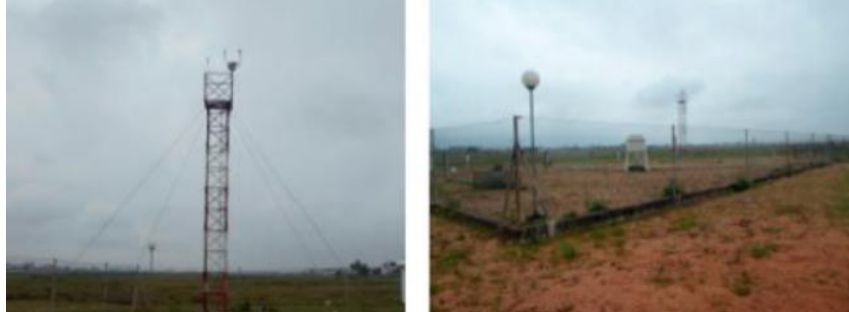
Figure 2. Experimental site of the Cotonou-Airport meteorological station. Anemometer with cup and wind vane located on a 10 m mast (left panel). Experimentation site (right panel)